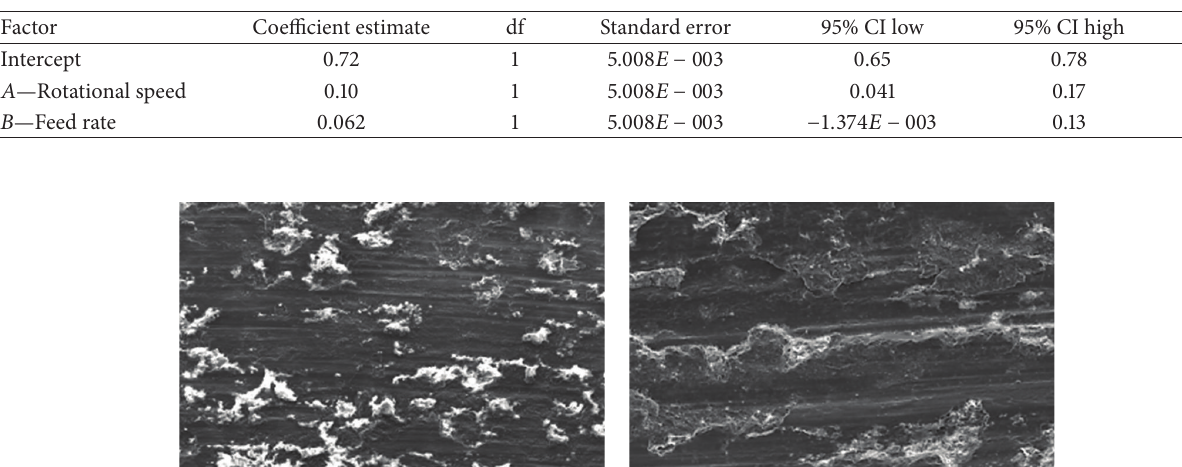
Table 6: The coefficient of the model terms.